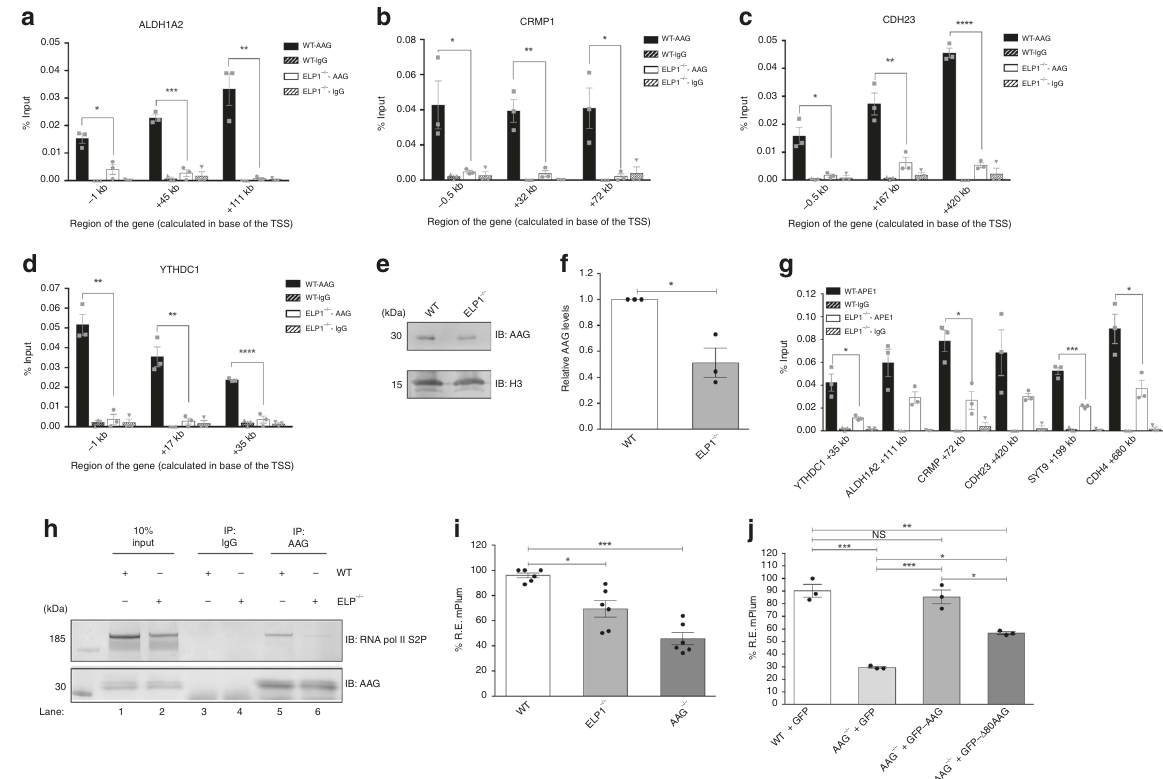
Fig. 5 Lack of functional Elongator hampers AAG and APE1 chromatin recruitment, and AAG-initiated repair. a – d ChIP-qPCR experiments comparing AAG occupancy at promoters and gene bodies of ALDH1A2 ( a ), CRMP1 ( b ), CDH23 ( c ), and YTHDC1 ( d ) in HEK293T WT and ELP1 − / − cells. e Immunoblot analysis of AAG levels in chromatin fraction of HEK293T WT and ELP1 − / − cells. Histone H3 served as control. f Quanti fi cation of experiments as the one depicted in e . g ChIP-qPCR experiments comparing APE1 occupancy at gene bodies of YTHDC1 , ALDH1A2 , CRMP1 , CDH23 , SYT9, and CDH4 in HEK293T WT and ELP1 − / − cells. Error bars represent the SEM calculated from at least three independent experiments. h Immunoprecipitation of AAG from HEK293T WT and ELP1 − / − whole cell extracts showing the interaction with RNA polymerase II phosphorylated at Serine 2 (S2P) of CTD repeat. i Measurement of AAG DNA glycosylase activity in HEK293T WT, AAG − / − and ELP1 − / − on hypoxanthine (Hx)-containing plasmid by FM-HCR assays. j AAG DNA glycosylase activity determined by FM-HCR assays on hypoxanthine (Hx)-containing plasmid in HEK293T WT cells complemented with GFP and AAG − / − cells complemented with GFP, GFP-AAG or GFP- Δ 80 AAG. Error bars represent mean ± SEM ( n ≥ 3). Two-tailed Student ’ s t -test ( a – d , f , g ); one-way ANOVA ( i , j ), NS – non signi fi cant, * p ≤ 0.05, ** p ≤ 0.01, *** p ≤ 0.001, **** p ≤ 0.0001. Source data are provided as Source Data fi